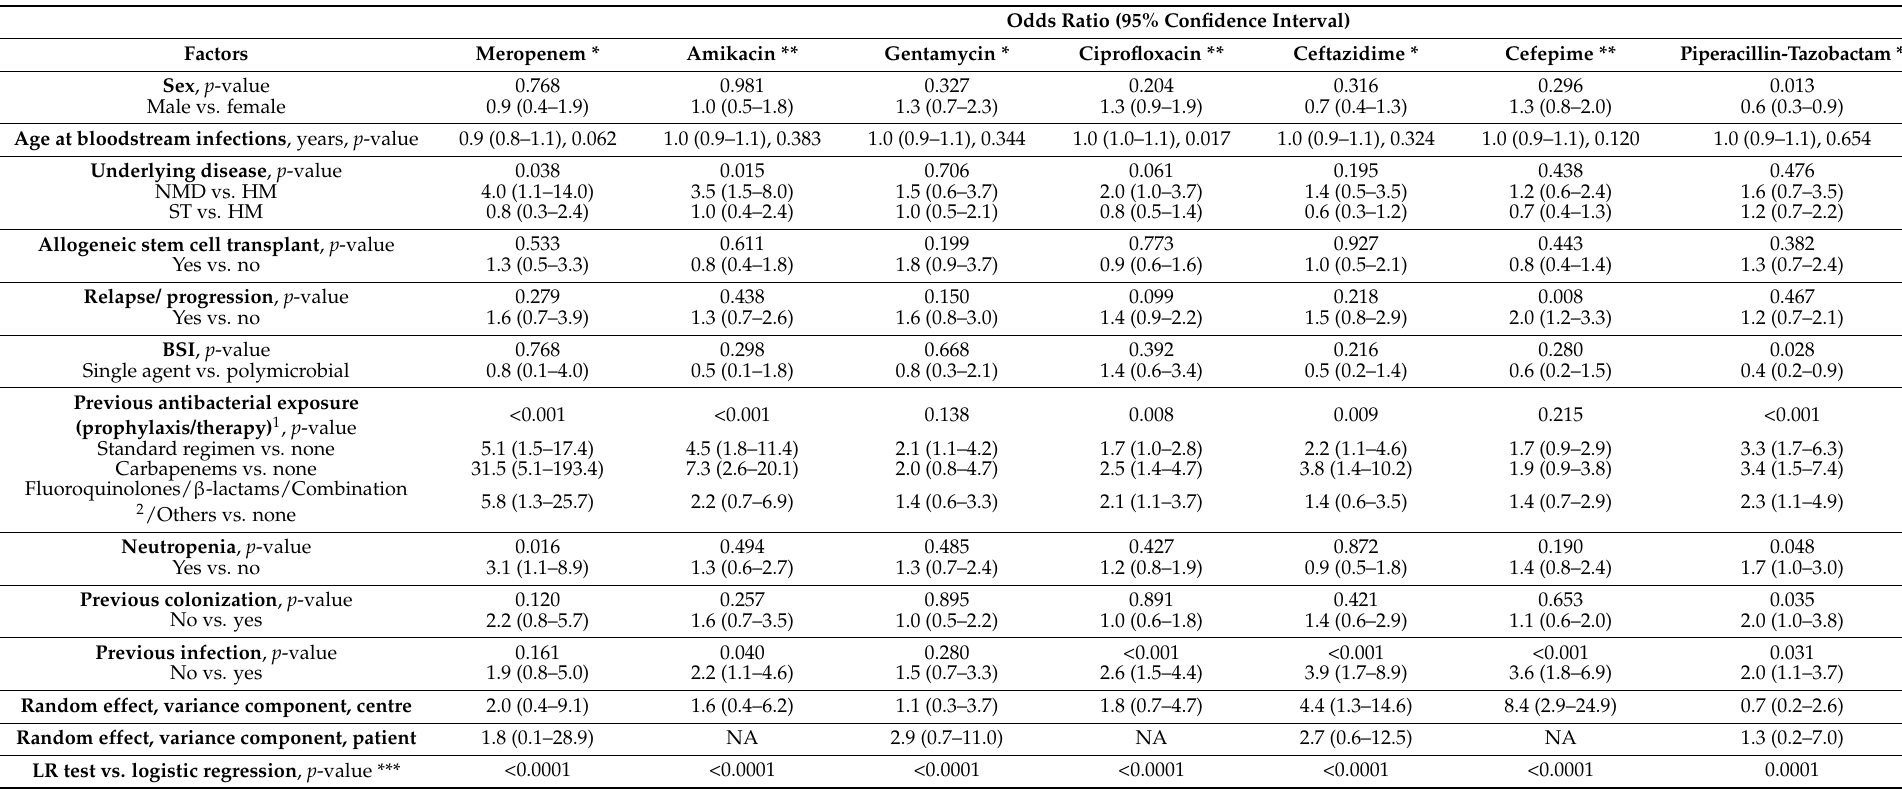
Table 2. Multivariable logistic regression models for BSI due to antibiotic resistant Gram-negatives ( n =